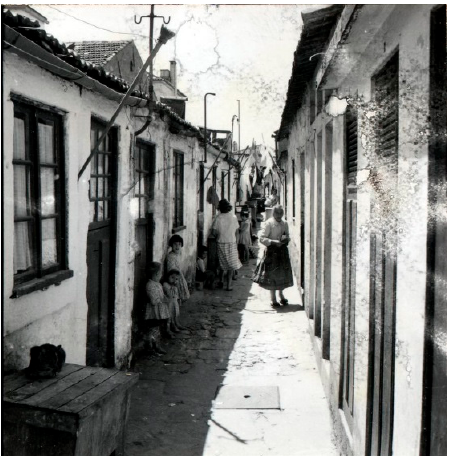
Figure 2. Interior of an “Ilha” in Porto, Portugal. Photographic survey by Câmara Municipal do Porto, circa 1960.